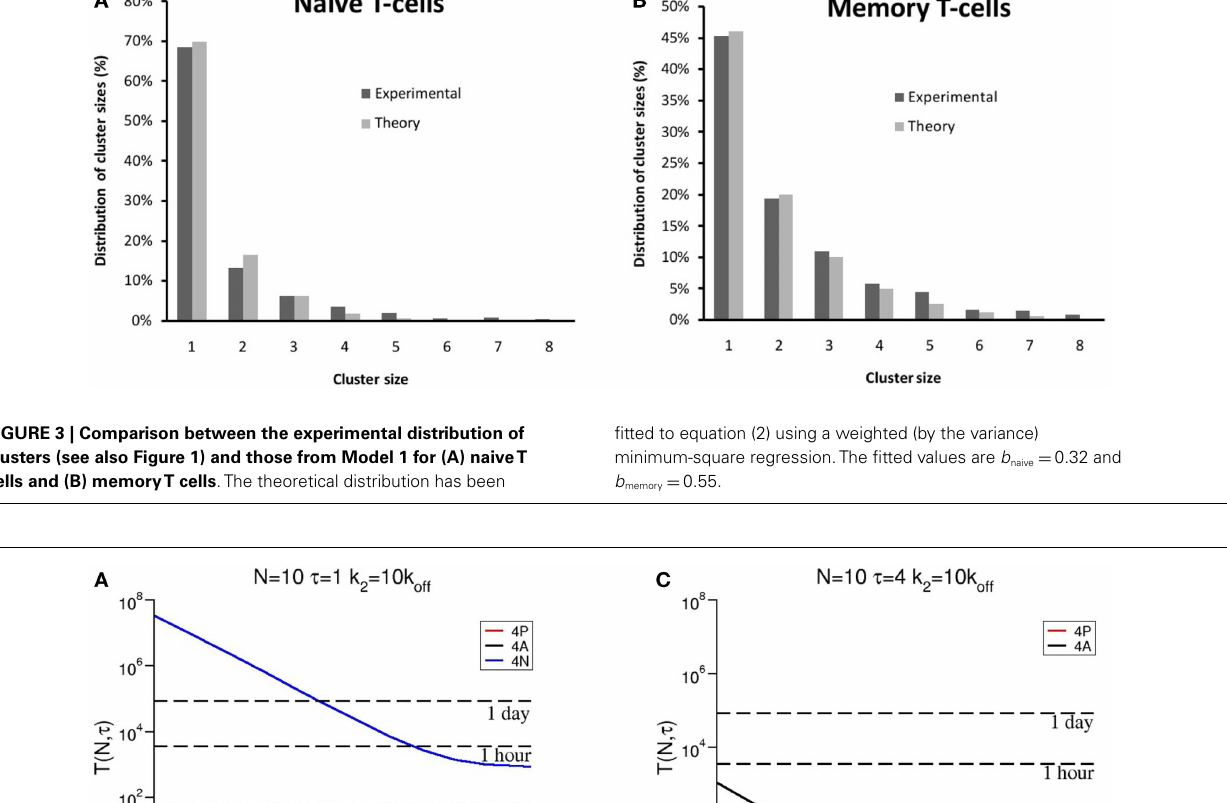
FIGURE 3 | Comparison between the experimental distribution of clusters (see also Figure 1) and those from Model 1 for (A) naiveT cells and (B) memoryT cells .The theoretical distribution has been